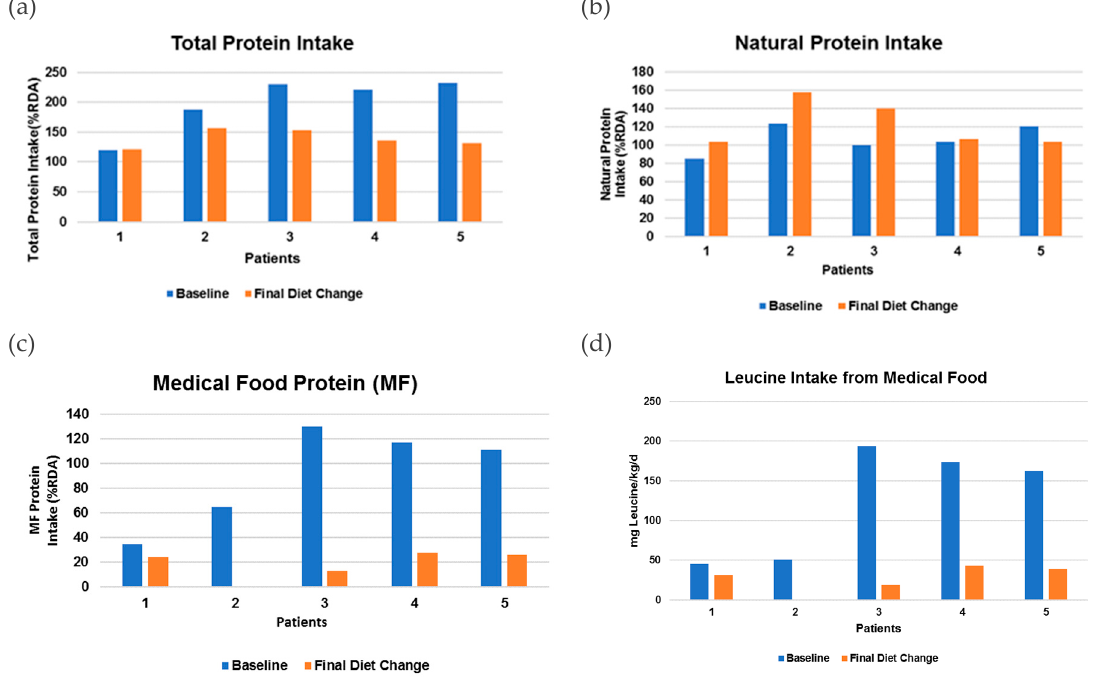
Figure 1. Changes in intake for each patient from baseline to final diet change. The Recommended Dietary Allowance (RDA) for protein intake was calculated based on the Institute of Medicine guidelines [7]. ( a ) Total protein intake from baseline to final diet change, p = 0.035; ( b ) natural protein intake from baseline to final diet change, p = 0.204; ( c ) medical food intake from baseline to final diet change, p = 0.014; and ( d ) leucine intake from medical food from baseline to final diet change, p = 0.0276.